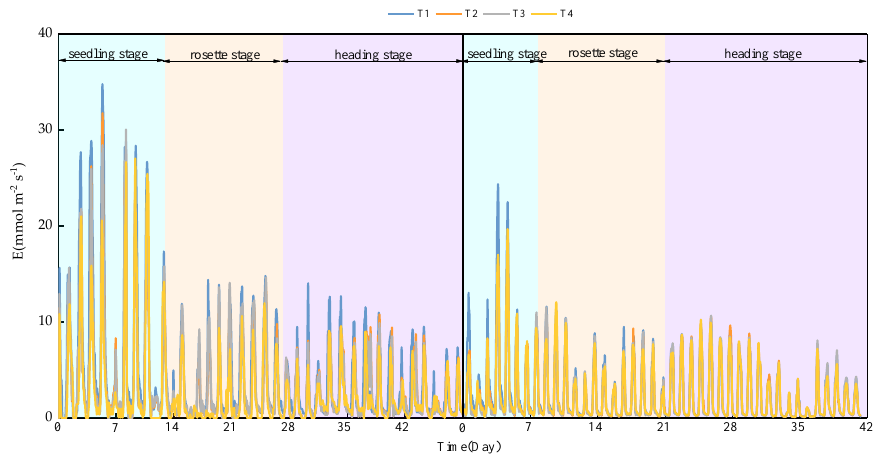
Figure 8. E changes under different water treatments.